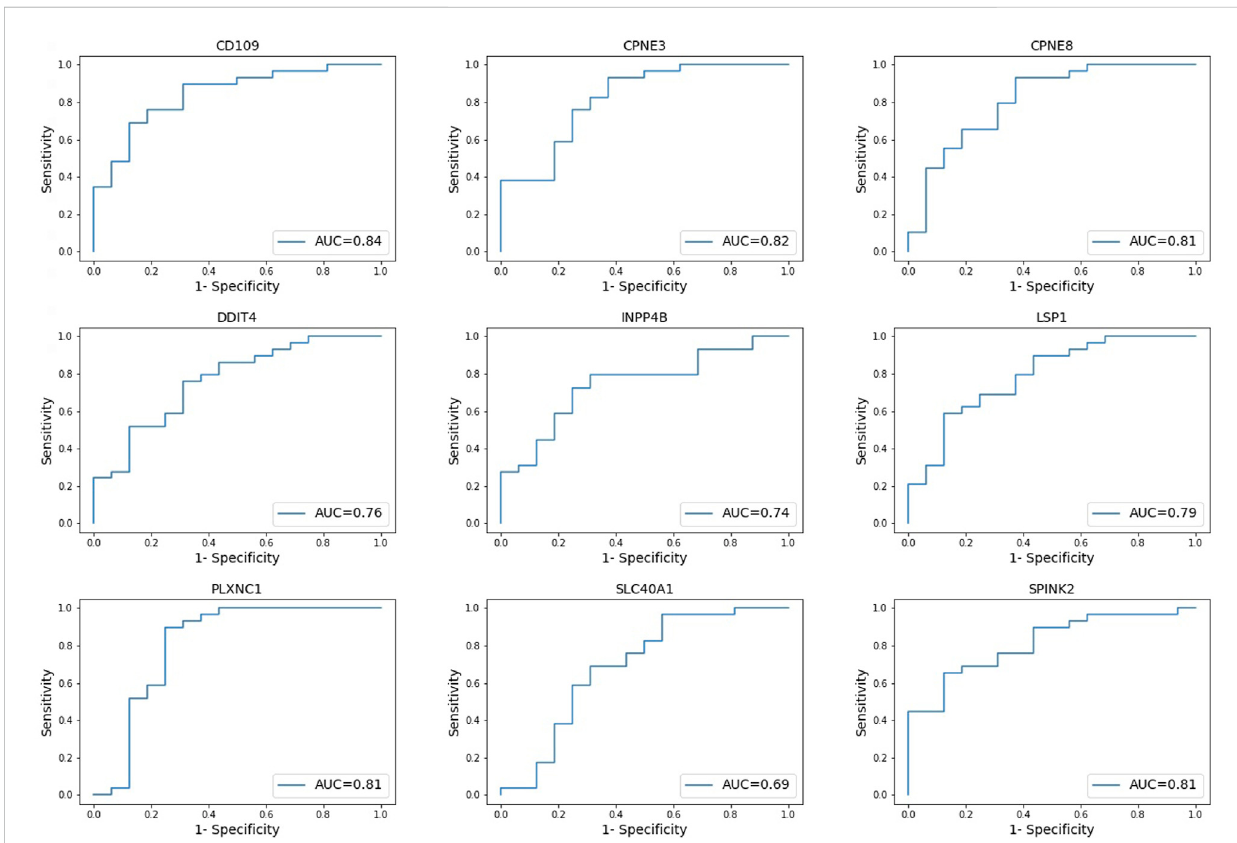
FIGURE 4 Receiver operating characteristic (ROC) curves. Evaluating the accuracy of high and low gene expression pro fi les of the nine-genes model in AML patients. *AUC = area under